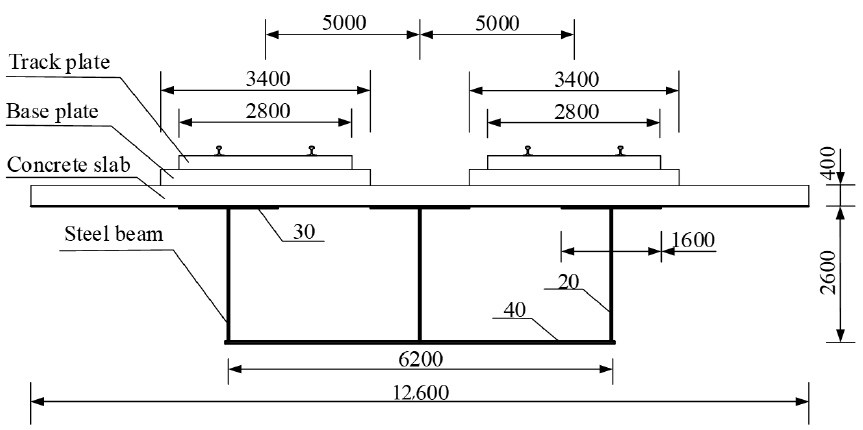
Figure 18. Cross-section diagram of composite beam with CRTS II ballastless track (mm).